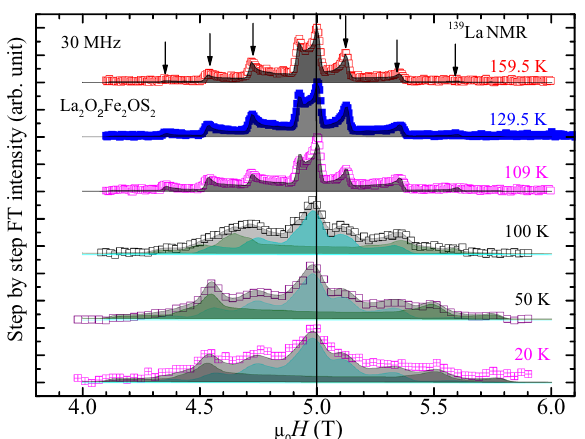
Fig. 6 139 La spin-lattice relaxation rate of La 2 O 2 Fe 2 O(S, Se) 2 . Temperature dependence of the 139 La spin-lattice relaxation rate of La 2 O 2 Fe 2 OS 2 ( fi lled circle) and La 2 O 2 Fe 2 OSe 2 ( fi lled square) 17 . Lines indicate the activation gap model (cid:5) T 2 exp ð(cid:2) Δ = T Þ . Dotted vertical lines denote the AFM ordering temperature. Inset shows the 1/ T 1 T versus temperature, while arrow marks the temperature regime where principal component V zz of the EFG start to